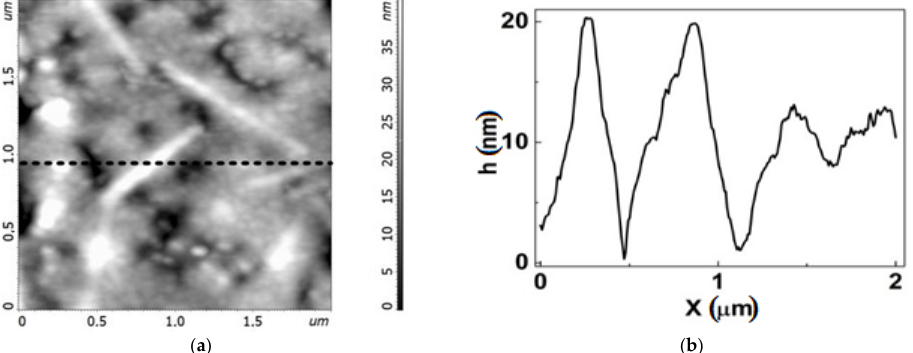
Figure 4. Topography of the graphene surface for chip EG392-1 from Group 2 before functionalization. ( a ) AFM image of the surface with bright areas. ( b ) AFM profile of the graphene surface along the dashed line in ( a ), showing the characteristic arrangement of the nanomaterial of the surface. Bright areas are equivalent to peaks with large magnitude on the profile curve. Biosensors 2022 , 12 , 8